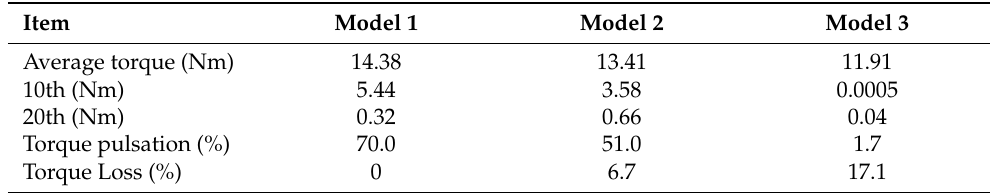
Table 6. The amplitude of torque harmonics in the three models.